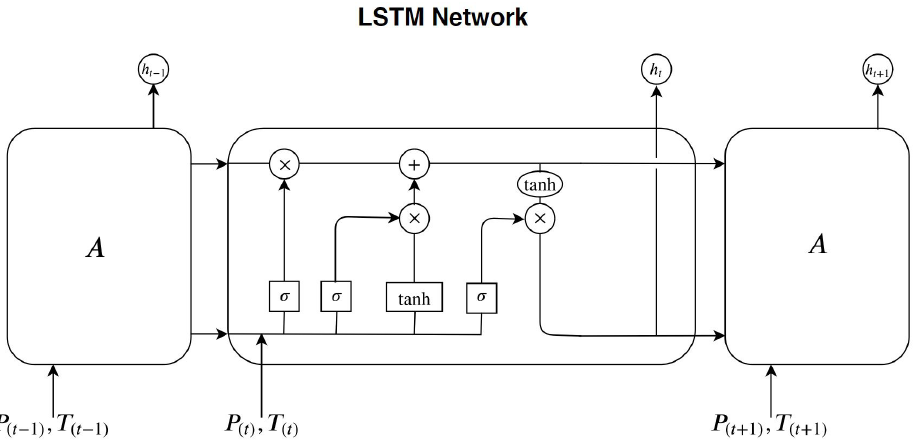
Figure 3. LSTM network for load